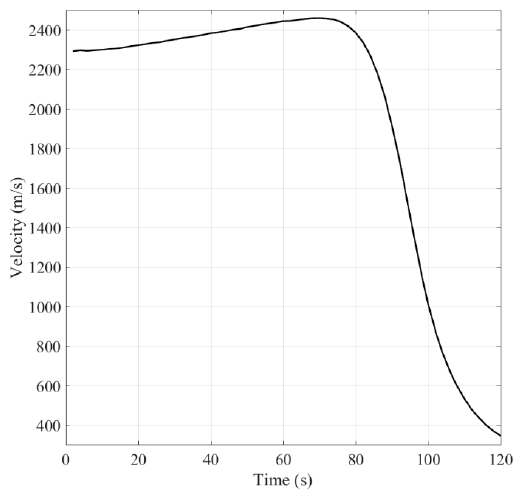
Figure 5. Velocity of ballistic target against time